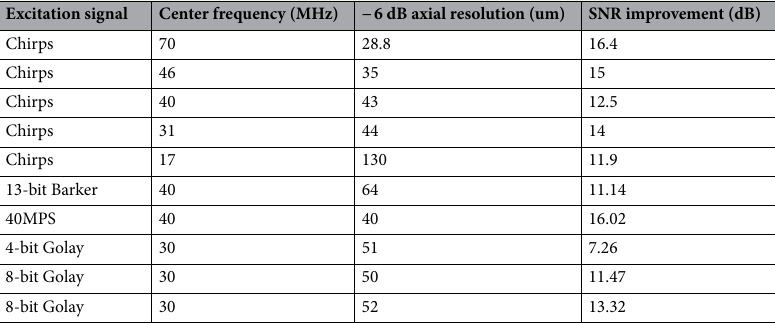
Table 1. Comparison between our experimental results and other code results from the